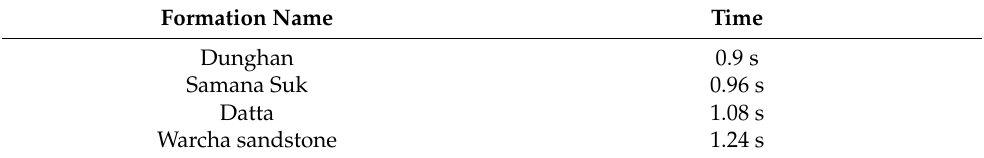
Table 5. Marked horizons obtained from time-depth chart estimated in Tola-01 well.